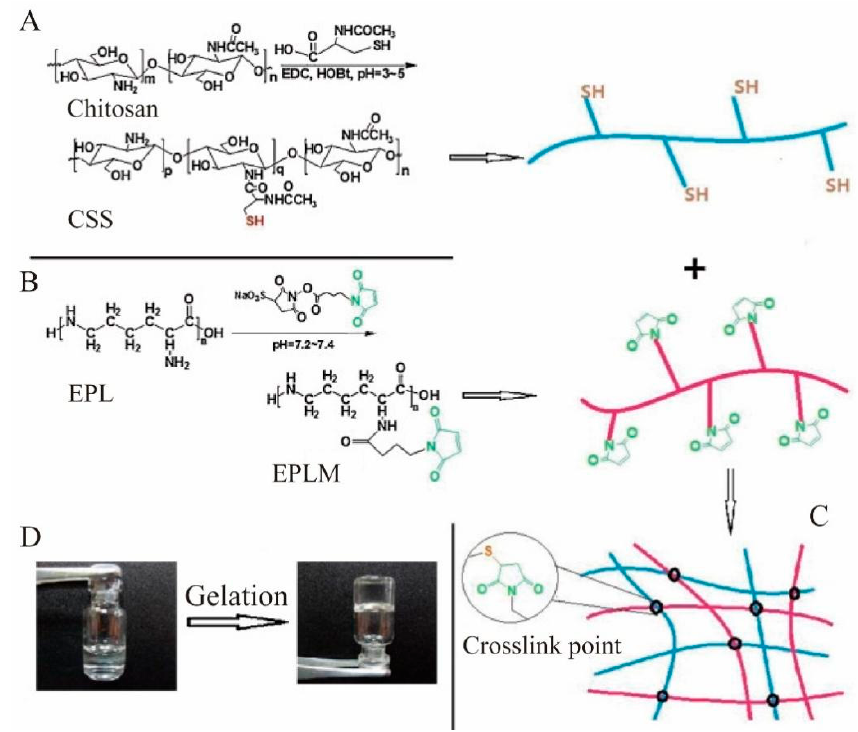
Figure 3. ( A ) Schematic diagram of CSS synthesis; ( B ) schematic diagram of EPLM synthesis; ( C ) in situ hydrogel formation; ( D ) photographs of hydrogel formation [81]. Copyright: 2013 Elsevier.